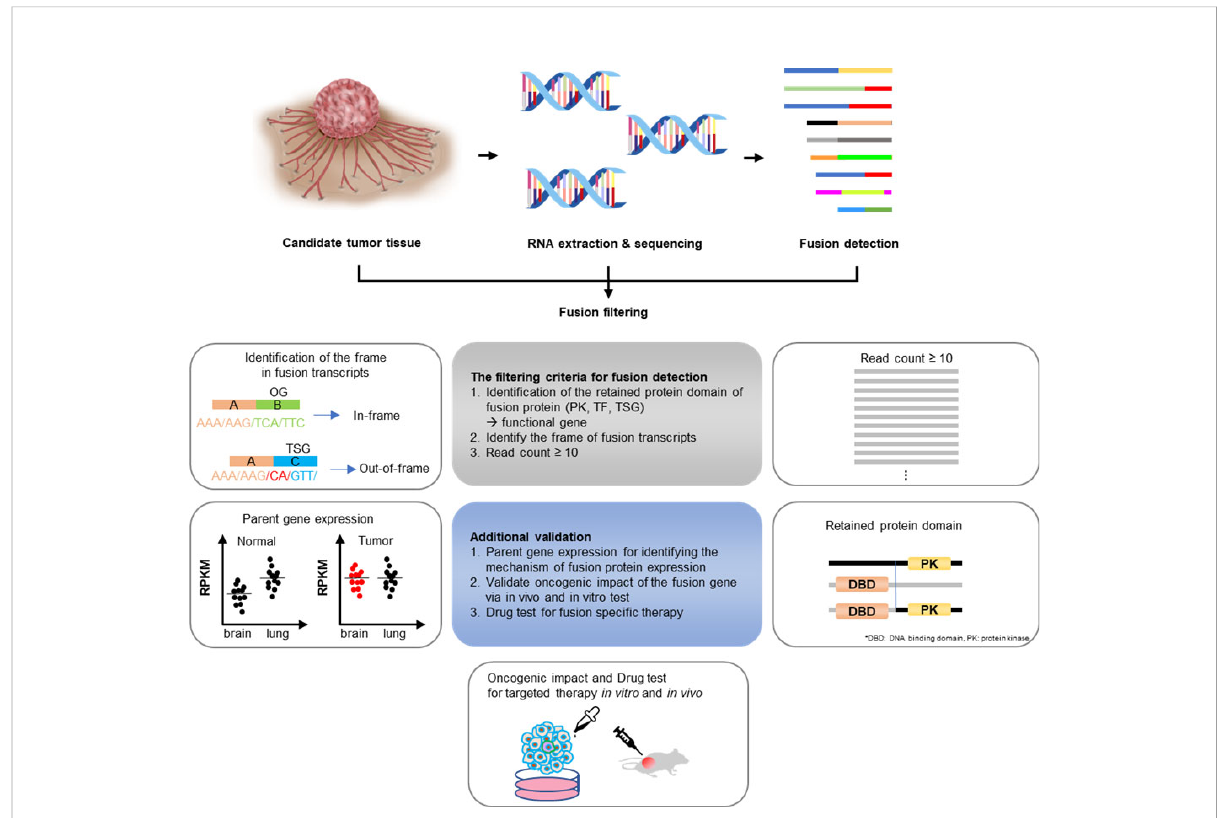
FIGURE 6 Gene fusion detection work fl ow. If the fusions are expected to be present in cancers whose exact cause is not determined using the existing diagnostic methods, RNA was extracted from the tissues and targeted sequencing was conducted. The sequencing data were fi rst analyzed using the Archer pipeline. Candidate fusions were subsequently fi ltered further by gene distance, gene function, frame, and read count. Additional analyses were conducted, including checking for intact functional protein domains and the expression of parent genes in the tumor. Finally, a fusion expression plasmid was produced to conduct in vitro and in vivo